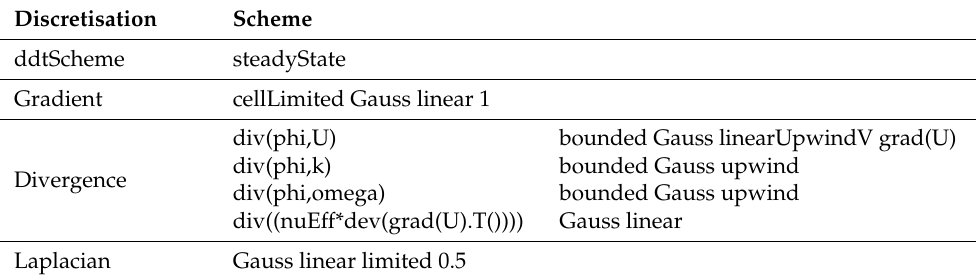
Table 3. Summary of the solver settings of the CFD